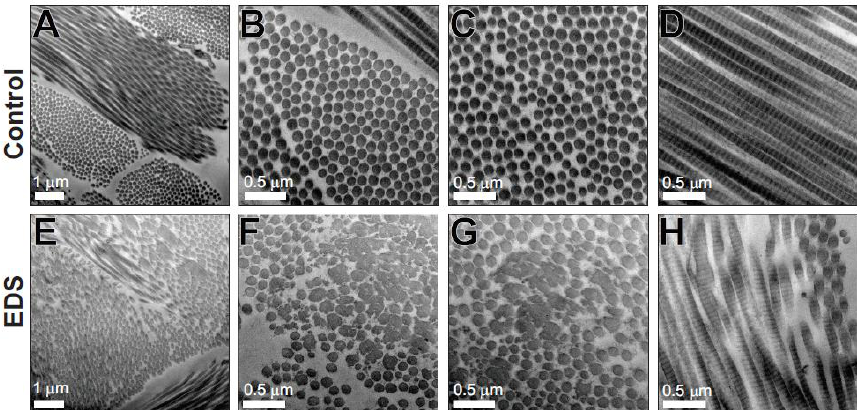
Figure 7. Structurally abnormal dermal collagen fibrils in Case 1. Transmission electron micrographs from the dermis of control ( A – D ) and Case 1 (EDS) ( E – H ). Control dermis contains well-organized collagen fibrils of uniform size and circular profile, while the EDS dermis contains two populations of fibrils. One fibril population is similar to the control dermis, whereas the other heterogeneous population contains large and structurally abnormal fibrils. Scale bars of 0.5 µ m or 1 µ m are shown.